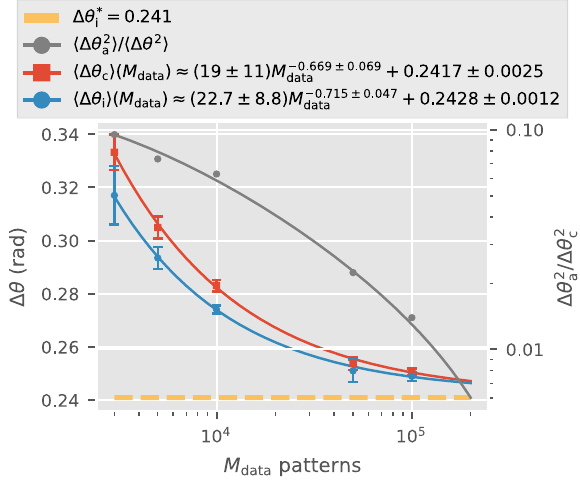
Figure 7. Orientation disconcurrence ( �θ c ) and inconsistency ( �θ i ) converge to �θ ∗ i as the number of patterns ( M data ) increase. Each dot and its error bars represent the average and standard deviation of �θ of all pairs among five reconstructions from four different disjoint datasets (average of 355 photons/pattern, rotation group sampling n = 13 ). The same 1000 sentinel patterns are used in all four instances. The ratio of orientation disagreement �θ a to disconcurrence �θ c , which is represented by the grey curve (labeled on right vertical axis), decreases with increasing M data